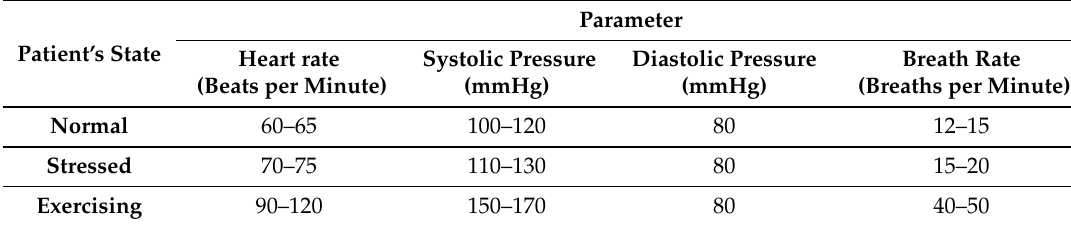
Table 2. Range of values used for training data for